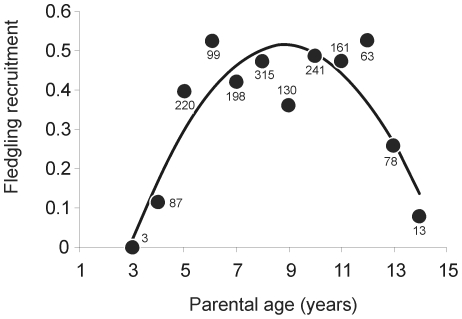
Parental age effects on fledgling recruitment.Circles represent the proportion of fledglings that recruited from each parental age class. Numbers next to circles are sample sizes.